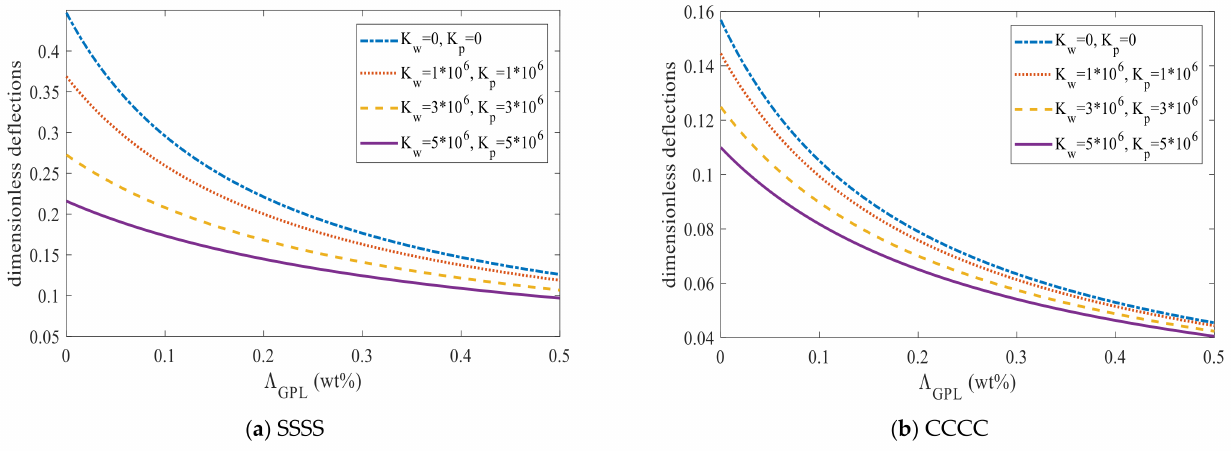
Figure 14. Dimensionless deflection vs. GPL weight fraction, for different elastic foundation coefficients ( b / a = 1, a / h = 10, GPL − X , p 0 = 10 5 ) : ( a ) SSSS boundary conditions, ( b ) CCCC boundary